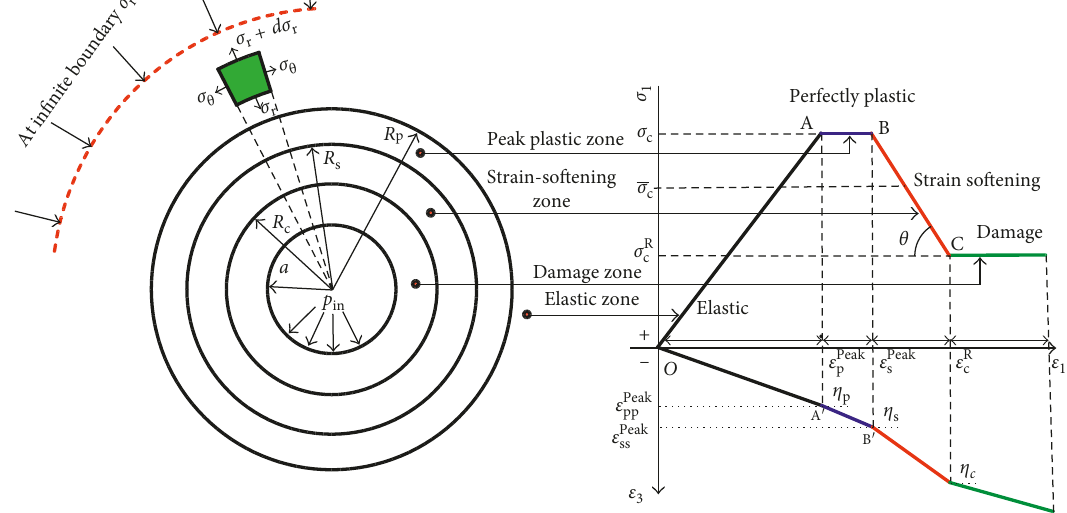
Figure 3: EPSDM of the circular